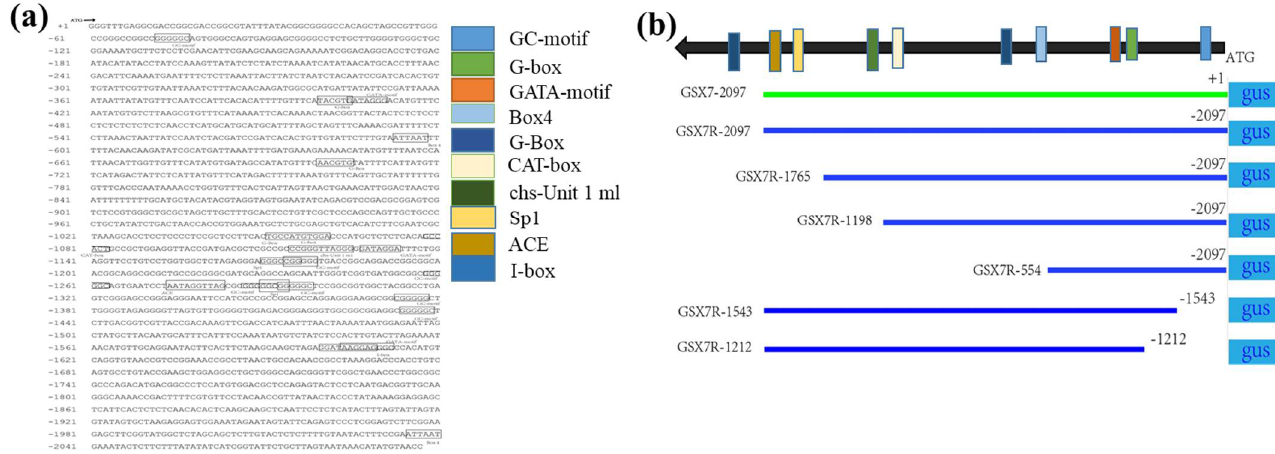
Figure 5. The location of putative cis -acting elements in GSX7R predicted by the PlantCARE database and schematic diagrams of promoter deletion constructs. ( a ) Putative cis -acting elements in GSX7R , The reverse 5′-region of the Os8GSX7 gene containing the 2097 bp promoter sequence from the translational start site. The transcription initiation site is defined as +1. The GC-motif, G-box, and other key cis-acting elements are underlined with and indicated by black frame as shown in the legend and different colors outside. The position of each element is also indicated by schematic diagrams; ( b ) The schematic diagrams of the truncated GSX7R constructs. The numbers to the left of these diagrams indicate the position of the 5′-deletion or 3′-deletion.